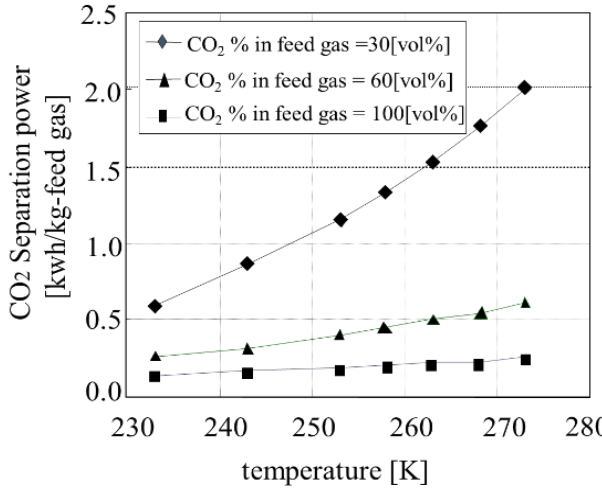
Figure 8. Relationship between hydrate formation energy and temperature at various concentrations of exhaust